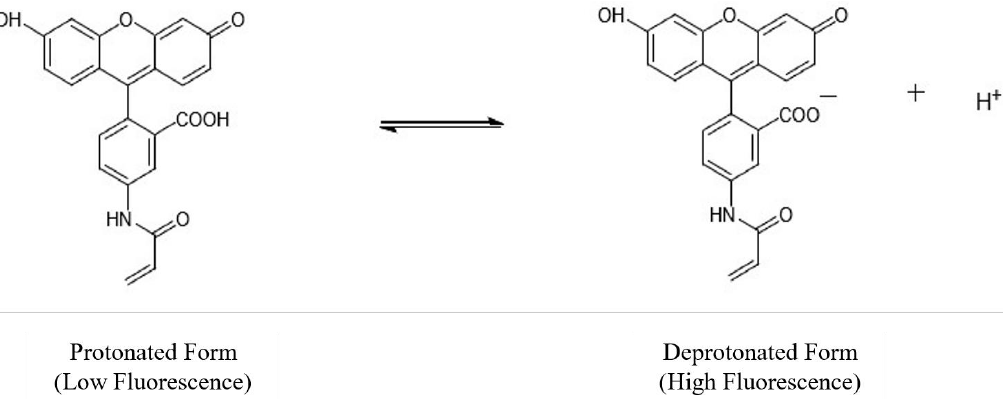
Figure 1. Schematic showing the equilibrium of protonated and deprotonated forms of the AAF dye in solution .